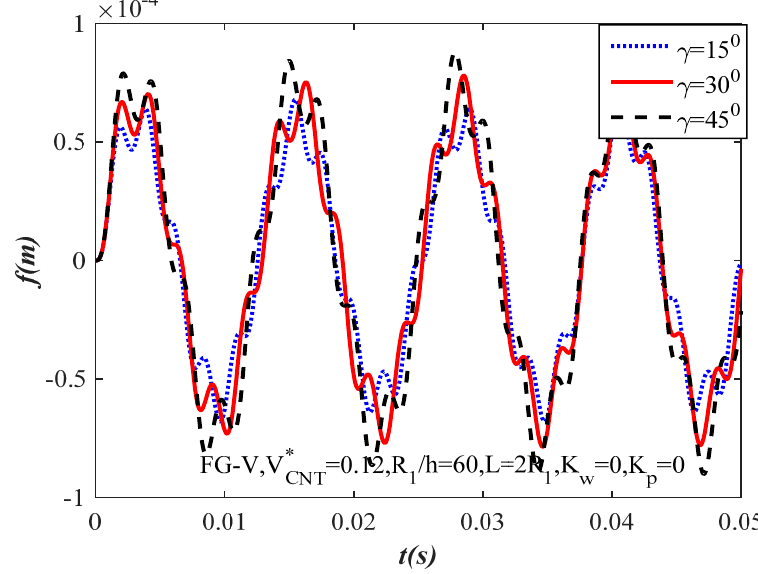
Figure 5. Effect of semi-vertex angle γ on the dynamic response of the FG-CNTRC truncated conical shells.